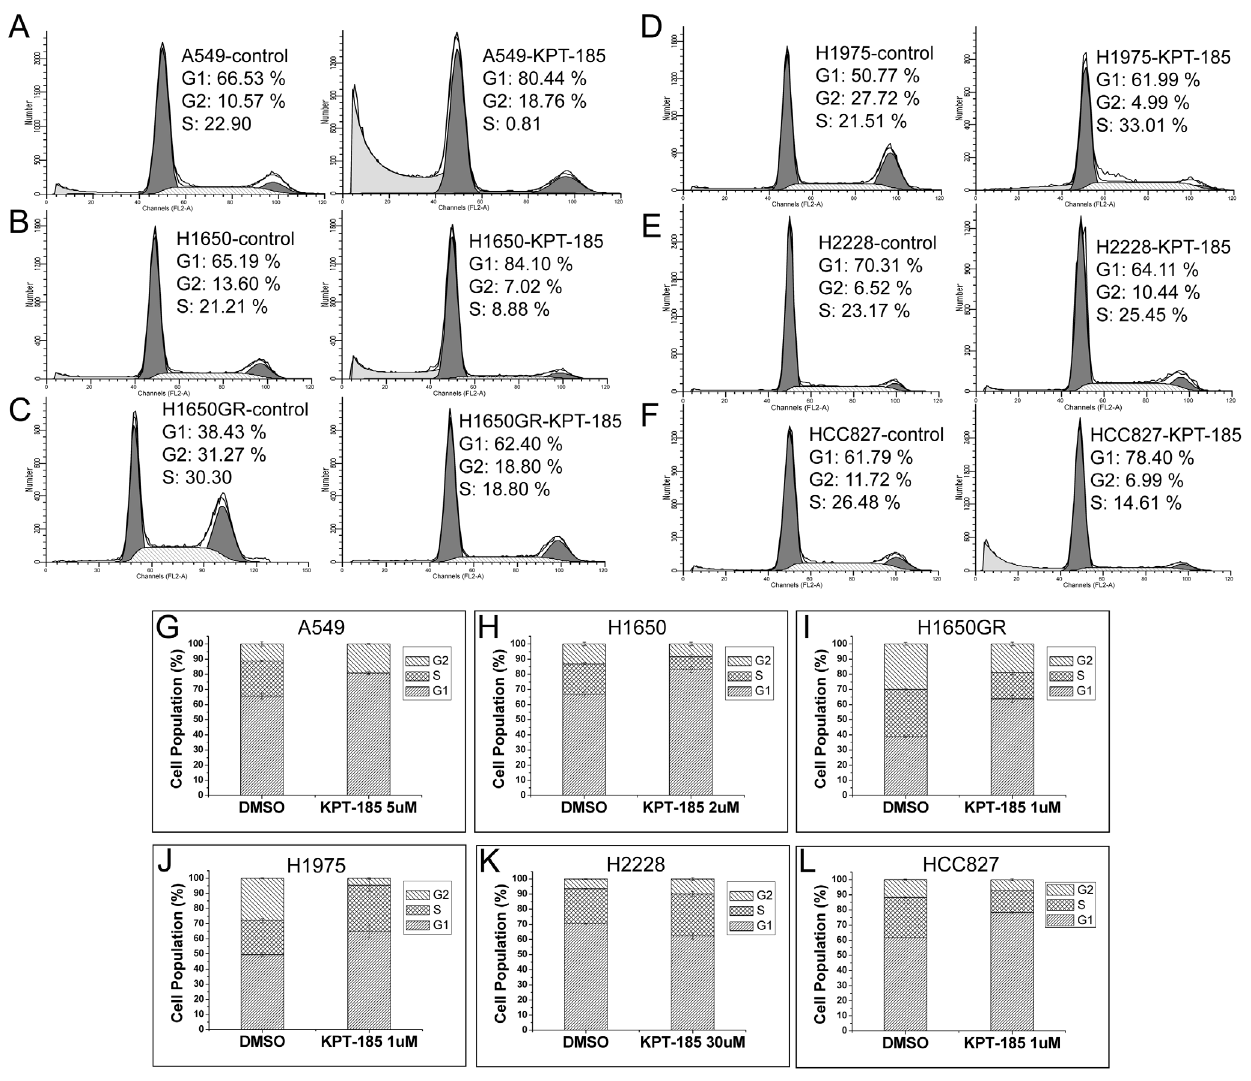
Figure 2. Effect of KPT-185 on the regulation of NSCLC cell cycle. Cells were arrested at the G1 phase of the cell cycle in KPT-185 sensitive cells. (N=3).